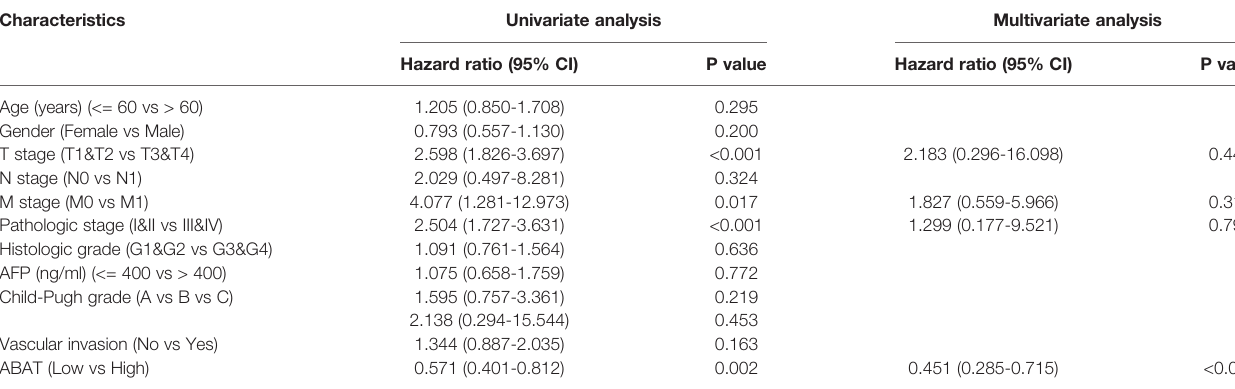
TABLE 2 | Univariate and multivariate Cox analysis of ABAT and other clinical pathological factors with OS in HCC patients.